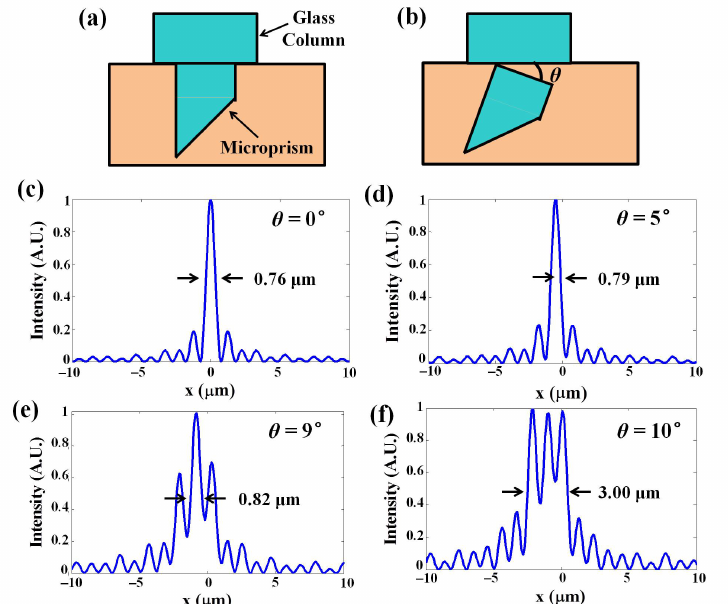
Figure 3. Simulations of microprism tilting. ( a , b ) Simulated intensity distributions with various tilt angles between the x axis and the glass surface, in the case of 0.5 NA and a 3-mm-thick glass at ( c ) 0º, ( d ) 5º, ( e ) 9º and ( f ) 10º